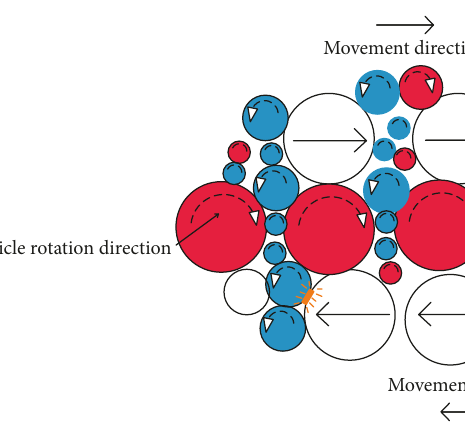
Figure 12: Illustration of particle